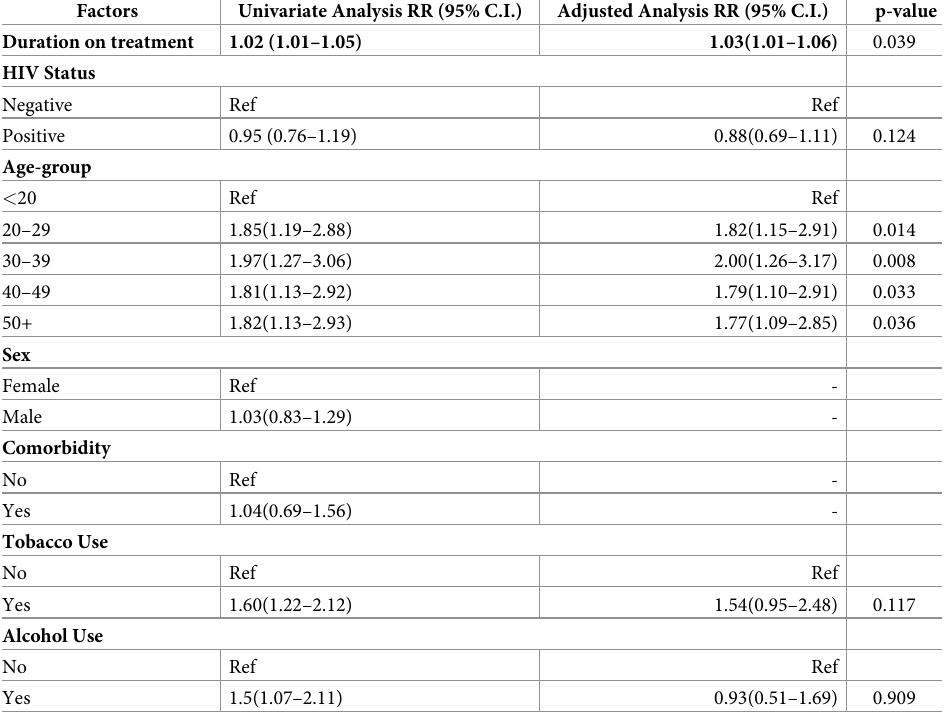
Table 2. Factors associated with treatment success among TB patients presenting for care at Elim